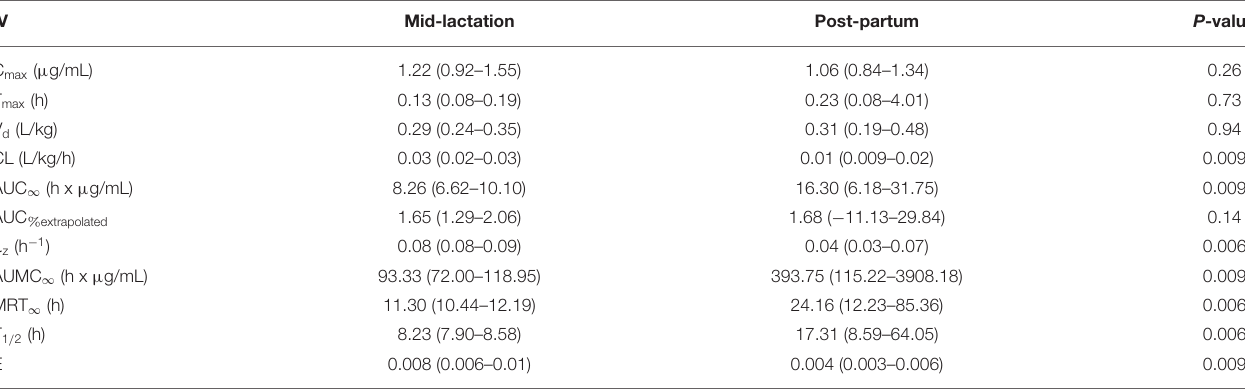
TABLE 4 | Plasma pharmacokinetic parameters for meloxicam from seven post-partum cows compared to five mid-lactation cows intravenously administered a single dose of meloxicam at 0.2 mg/kg.